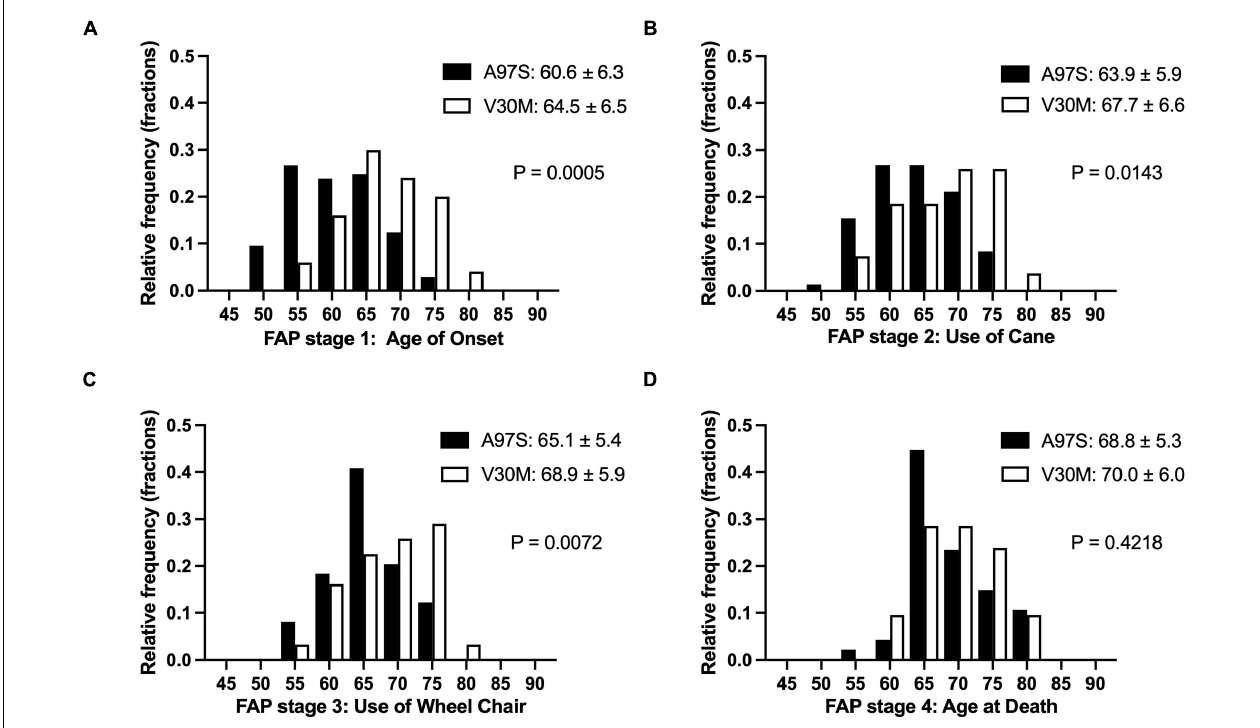
FIGURE 3 | The natural course of ATTRv of A97S and V30M: comparing the histogram of the age in each familial amyloid polyneuropathy (FAP) stage. The histograms of the age for each FAP stage are depicted between A97S Taiwanese vs. V30M Japanese patients (A–D) . At all stages, the A97S cohort had earlier onset age, i.e., entering FAP stage 1 (A) , and the age entering successive FAP stage (B–D)